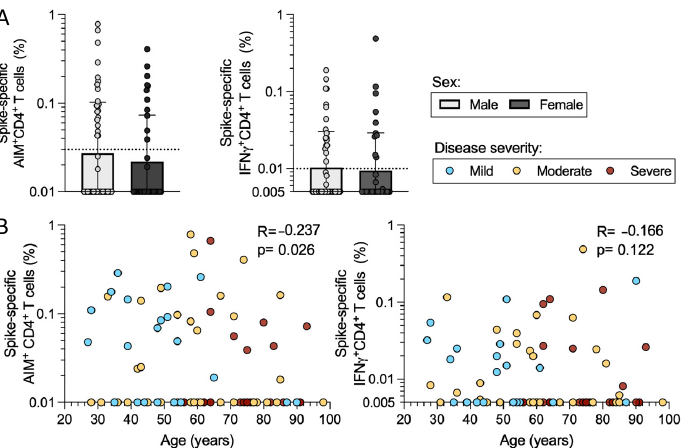
Figure 5. CD4+ T cell reactivity as a function of donor sex and age. The cohort of 89 acute COVID-19 donors was analyzed for CD4+ T cell responses to SARS-CoV-2 S by AIM + ICS assays. ( A ) The spike-specific AIM+ and IFN γ + CD4+ T cell responses are shown for the entire cohort as a function of donor sex (male in white and female in dark grey). The y-axis begins at the LOD for each assay and the dotted line represents the LOS. Mann–Whitney U tests were applied to the data and the results are indicated by symbols when significant. ( B ) The CD4+ AIM and IFN γ reactivity to S is shown as a function of donor age. Mild ( n = 21, blue), moderate ( n = 35, yellow), and severe ( n = 33, red) disease states are plotted together. R and p -values are calculated by Spearman